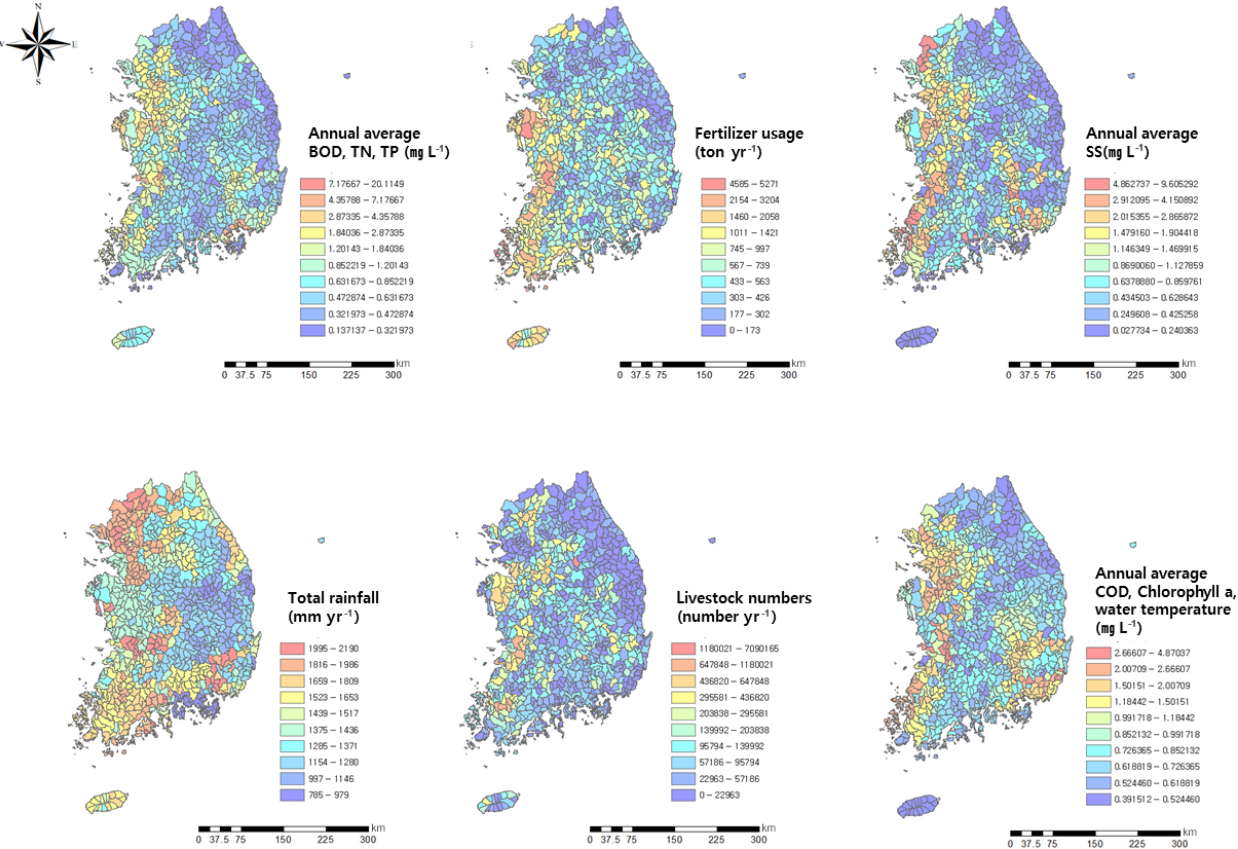
Figure 3. Sample of collected data